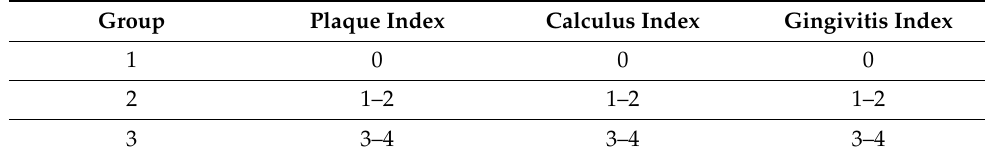
Table 2. Groups 1, 2, 3 and related Plaque, Calculus, and Gingivitis indexes.